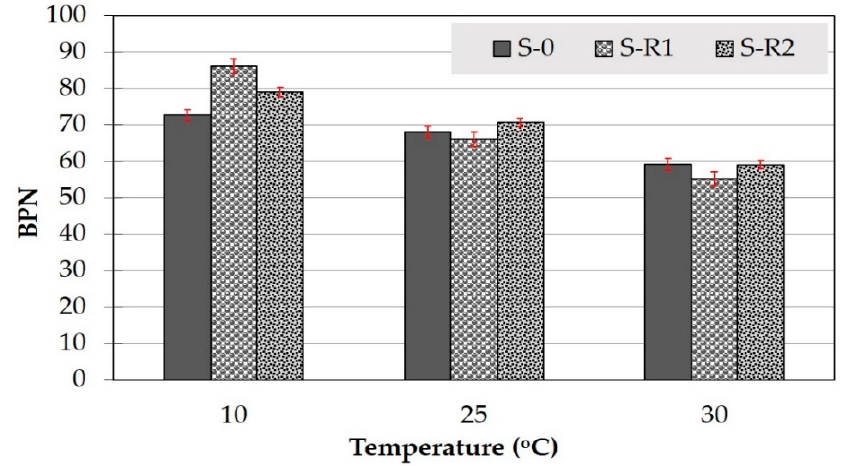
Figure 15. Temperature effect on the HMA-RAP specimens.